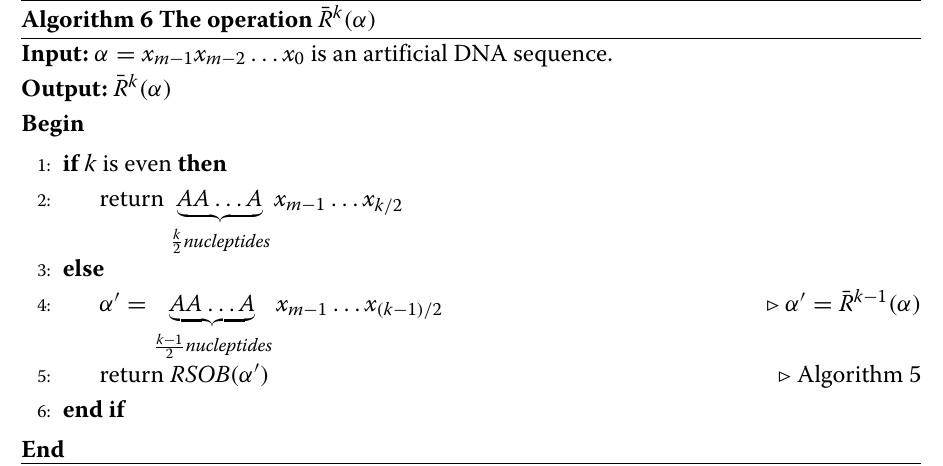
Algorithm 6 The operation